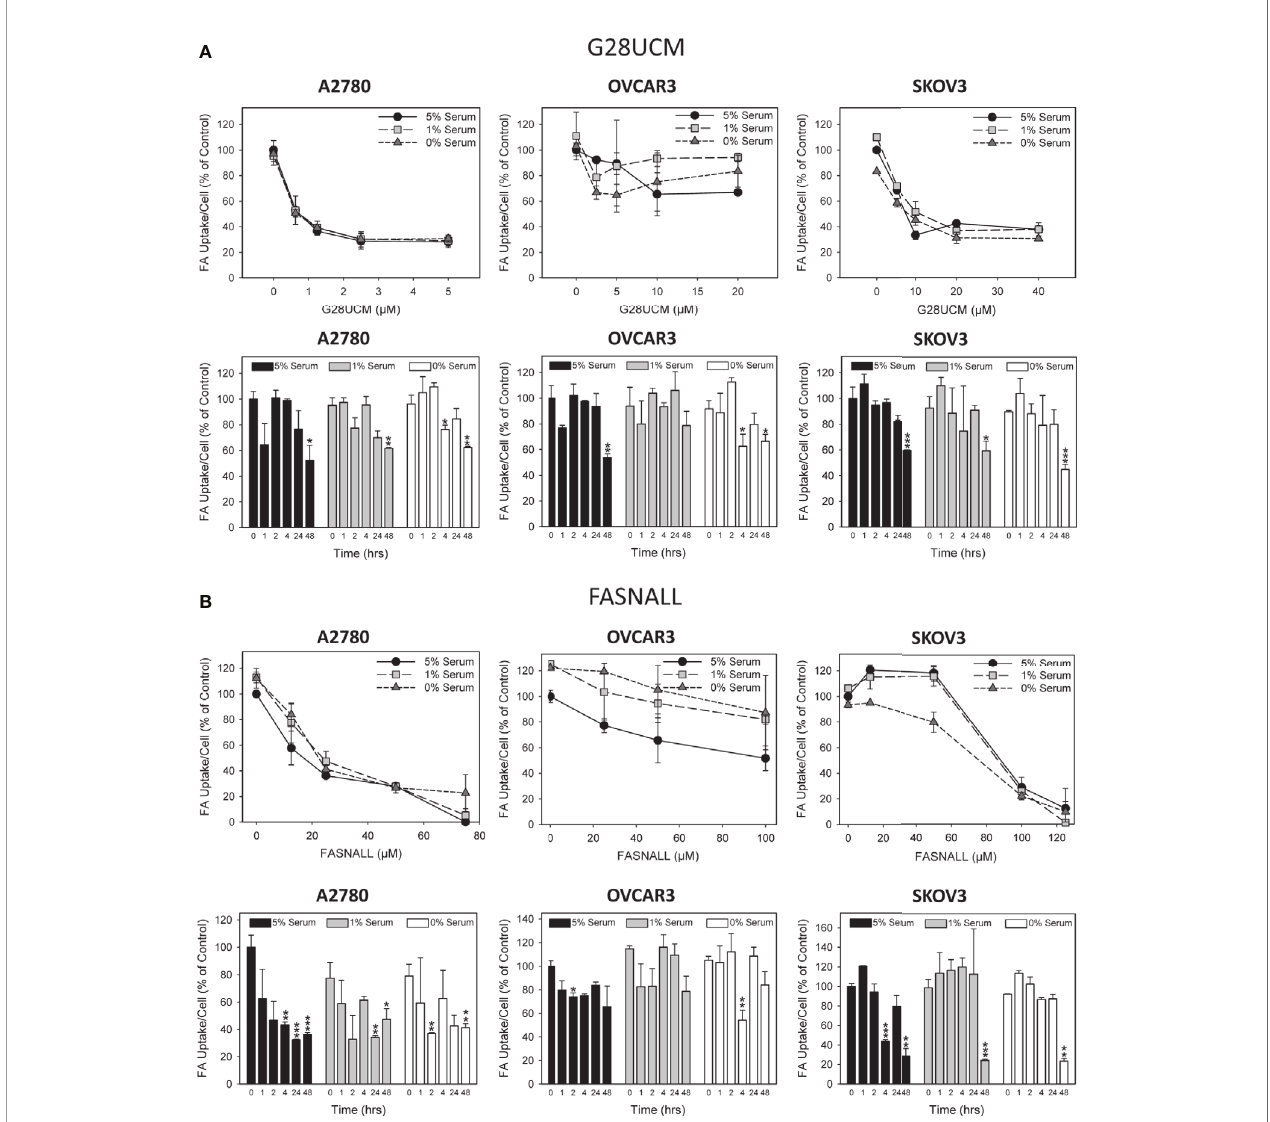
FIGURE 3 | The effect of inhibition of endogenous de novo fatty acid synthesis on the uptake of exogenously supplied FAs in OC cells. A2780, OVCAR3 and SKOV3 cells were exposed for 48 hours to increasing concentrations of the FASN inhibitors G28UCM (A) or Fasnall (B) before FA uptake was determined by the QBT ™ Fatty Acid Uptake Kit as described in Materials and methods. Obtained dose-response curves (upper panels in A , B ) were used to determine optimal drug concentrations (G28UCM: 1.25, 2.5, 10 µM for A2780, OVCAR3 and SKOV3; Fasnall: 25, 50, 100 µM for A2780, OVCAR3 and SKOV3) for subsequent time courses (lower panels in A , B ). Comparison of the data in the presence of 5%, 1% or 0% serum reveals that withdrawal of concurrent lipid contained in the serum could not reverse the drug-mediated reduction of uptake of the fl uorescent dodecanoic FA analog BODIPY 500/512 C1, C12. Fluorescence signals were normalized to cell numbers that have been determined in parallel by formazan dye cell proliferation assays and were expressed in % of vehicle(0.1% DMSO)-treated control cells grown in the presence of 5% serum. Means ± SD, n = 3. ANOVA followed by Scheffe test, p < 0.05 (*), p < 0.01 (**) and p < 0.001 (***) relative to vehicle-treated cells grown in the presence of the corresponding concentration (5%, 1% or 0%) of